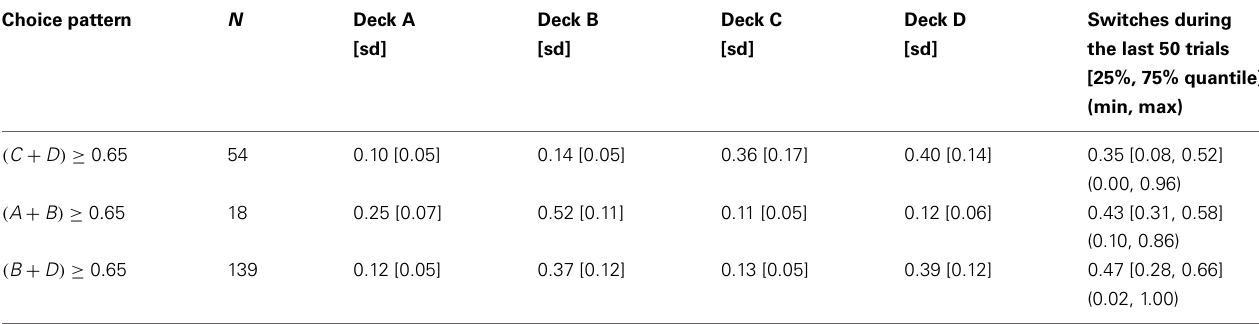
Healthy participants are selected from the Steingroever et al. (2013a) data pool (N =